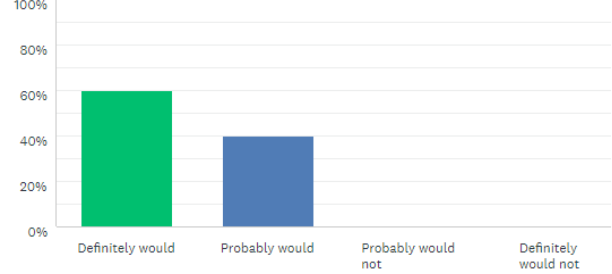
Figure 7. Respondent’s preference to